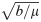
Critical slowing down is illustrated in the potential function of the linearized SIR model.Disease prevalence (I/N) is represented by the horizontal position of a ball sliding through viscous fluid in a well having a height determined by the potential function. Both the depth of the well and the viscosity of the fluid in the equivalent physical system are affected by vaccine coverage. The well is shallowest near the immunization threshold, which illustrates the slowing down of the dynamics as the critical point (νc ≈ 0.941; green dashed line) is approached. Oscillatory dynamics occur at another immunization level (ν ≈ 0.939) corresponding to the system becoming underdamped (pink region). Model parameters: b = 2 × 105 y−1, μ = 0.02 y−1, γ = 365/22 y−1, η = 2 × 10−5 y−1, R0 = 17. To write the potential function in terms of prevalence, we scaled the deviations of the linearized system by the square root of the equilibrium population size (i.e., scaled by b/μ). Critical slowing down is seen in this figure in the relative magnitude of the displacement of the ball with respect to the distance from the critical level of immunization.